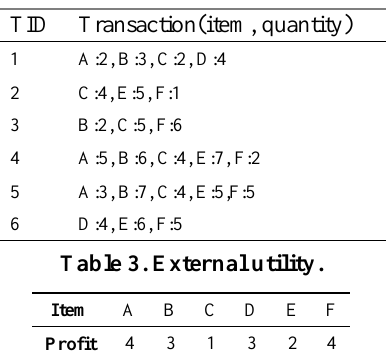
Table 2. A sample database.